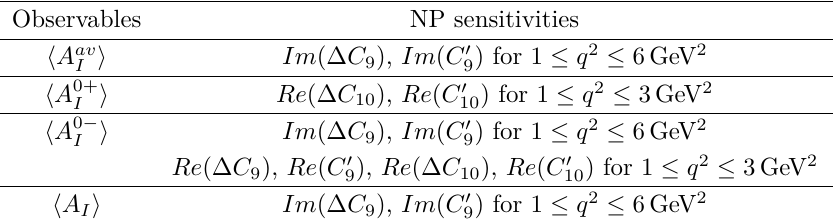
Table 17 . NP sensitivities of the isospin observables for B → ρ‘‘ defined in eqs. (4.20) and (4.23), re-